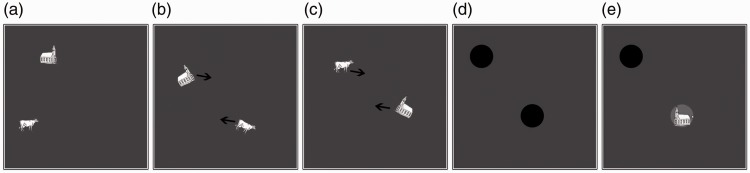
Illustration of the procedure in Experiment 5. First, targets
were assigned (a), then all objects started moving around the
display while frequently rotating 30° left and right (b), a
change in lateral orientation occurred at a random time point
between 2 and 6 seconds from start of tracking (c; notice that
the church changes lateral orientation, as signaled by the
position of the belfry). The movements stopped once a total of 8
seconds had elapsed or the observer pressed a button. Black
disks immediately occluded the objects as the movements stopped
(d). Participants then indicated the position of the changed
object (e). Images adapted with permission (Snodgrass
& Vanderwart, 1980, pp. 197–204).